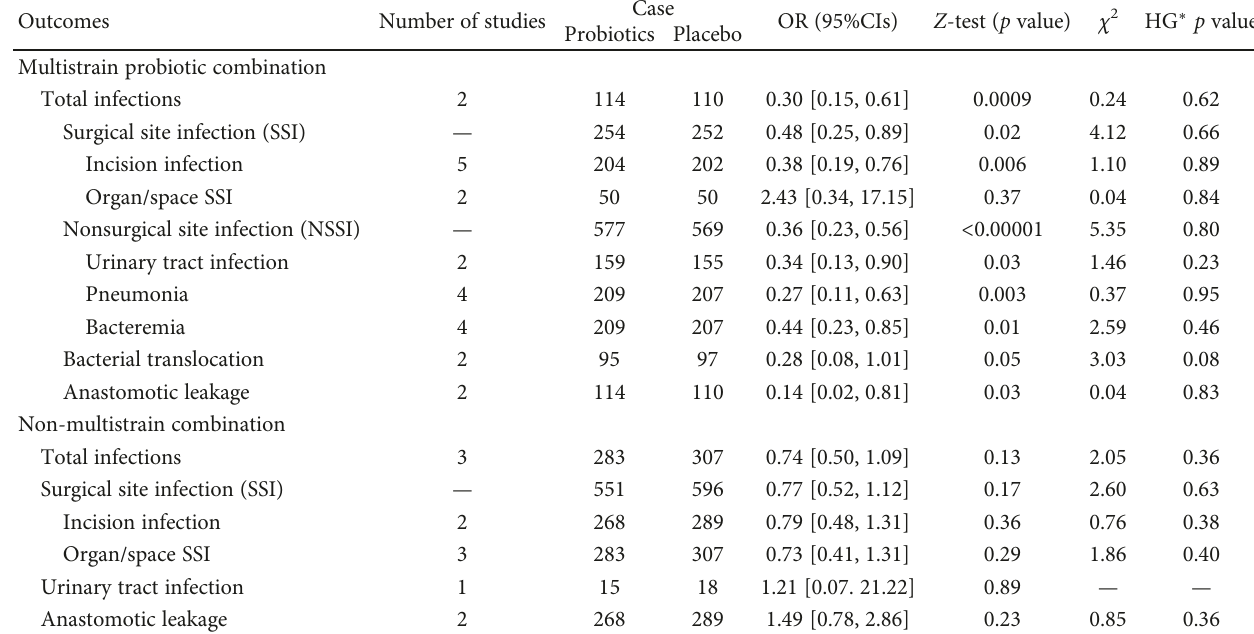
Table 3: Summary estimates and 95%CIs for e ff ects of di ff erent probiotics